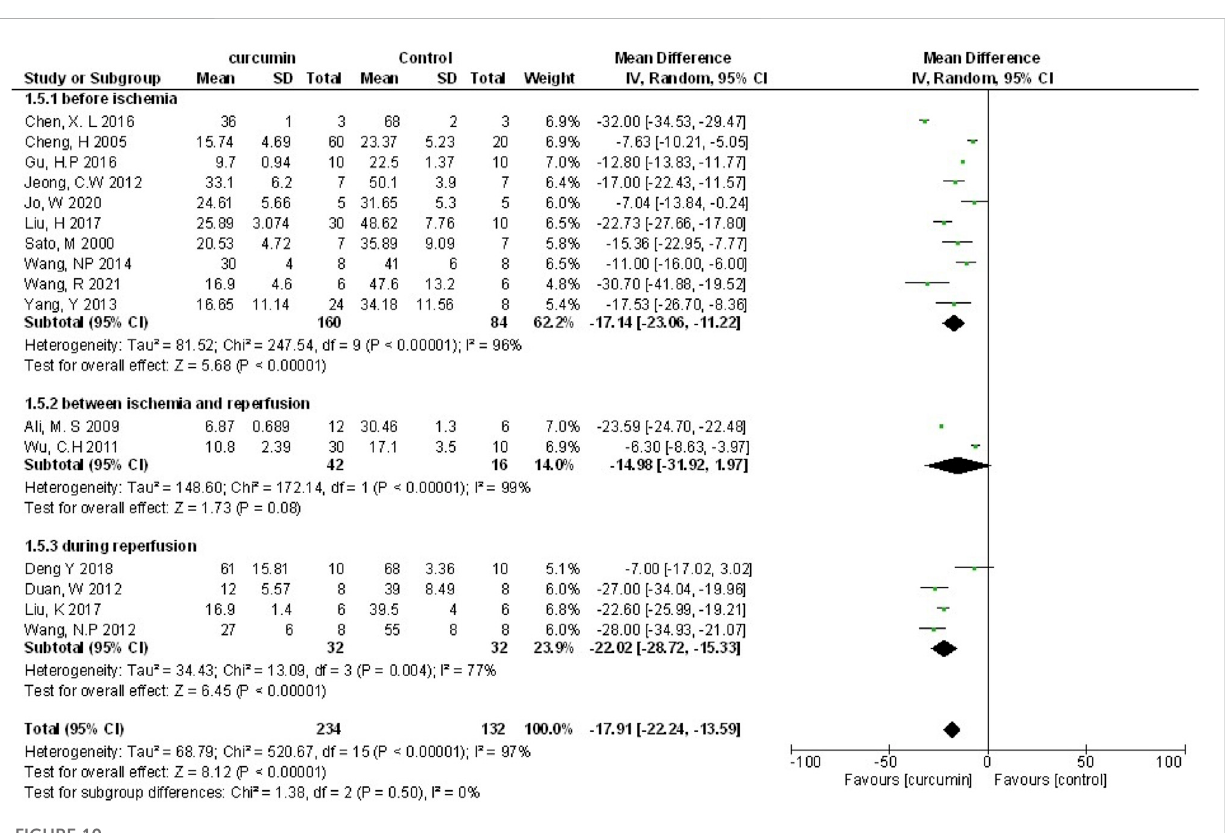
FIGURE 10 The subgroup analysis (intervention moment) of curcumin on MI